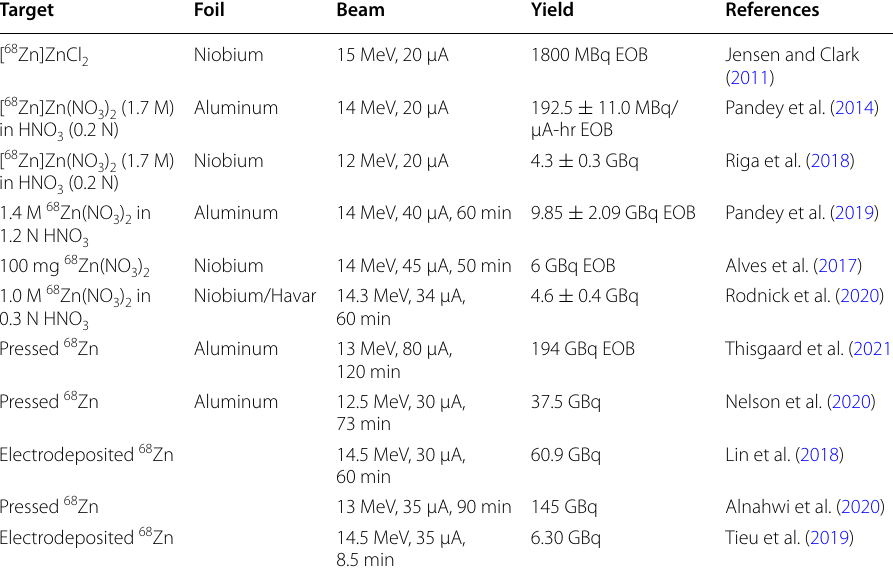
Table 2 Liquid and solid target 68 Ga cyclotron production routes